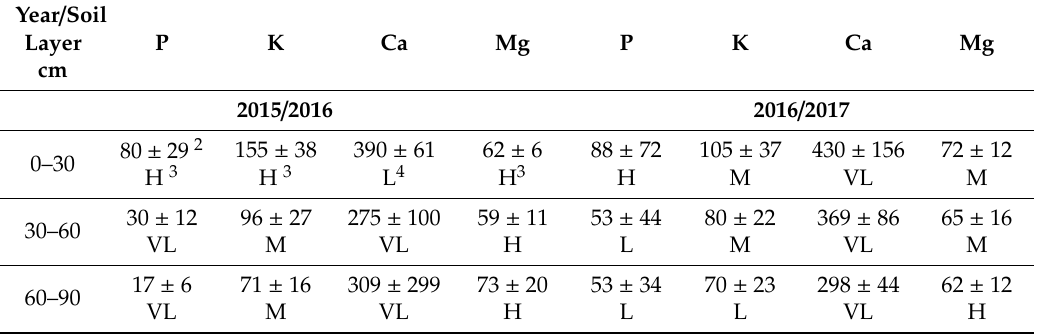
Table 1. Soil characteristics of the experimental plots in the consecutive growing seasons 1 , mg kg − 1